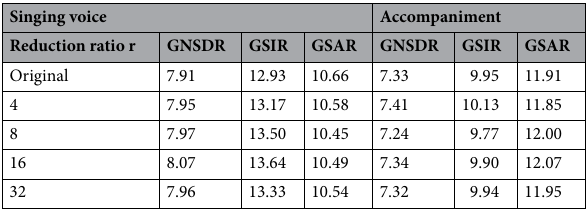
Table 4. The influence of reduction ratio r on separation performance after the network layer is deepened.